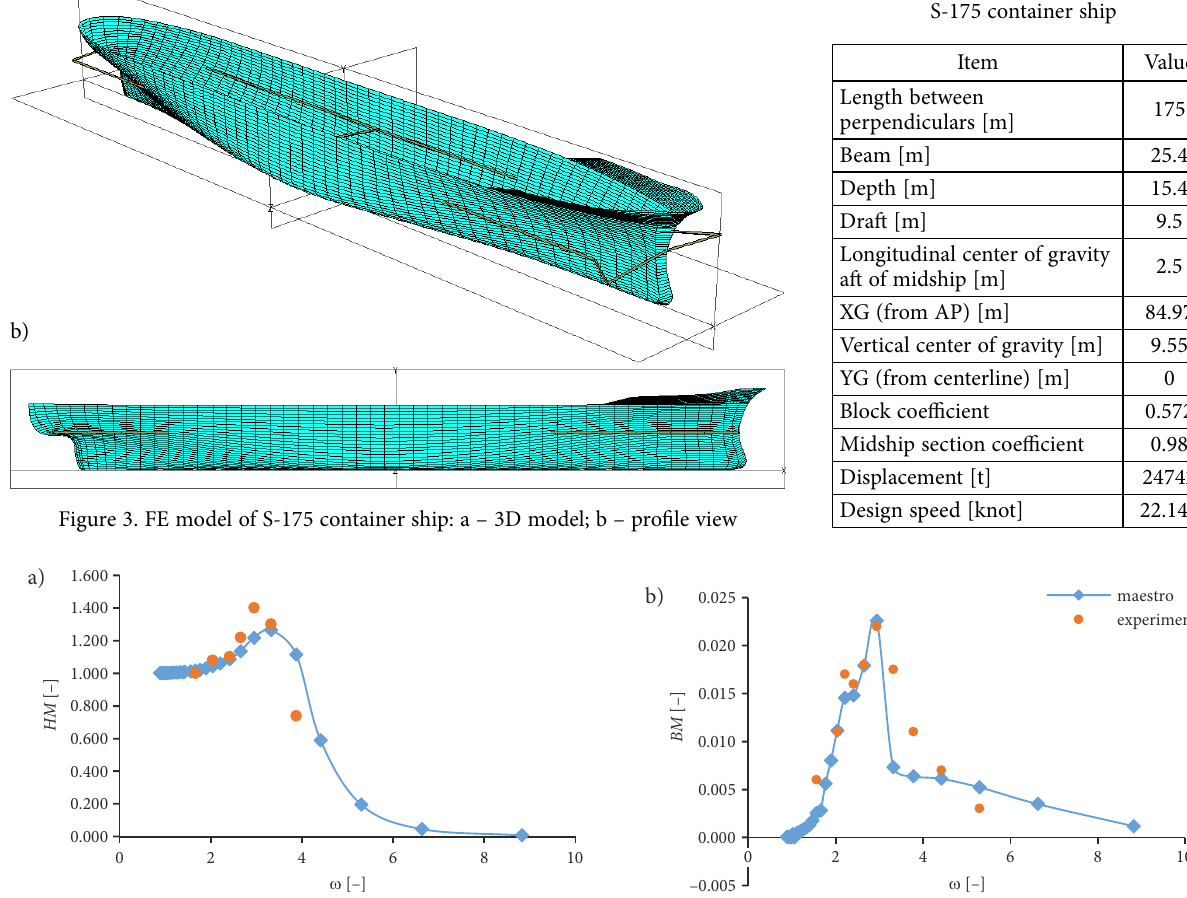
Figure 4. Heave motion HM in beam seas (a) and vertical bending moments BM (b) in head seas at F n = 0.275